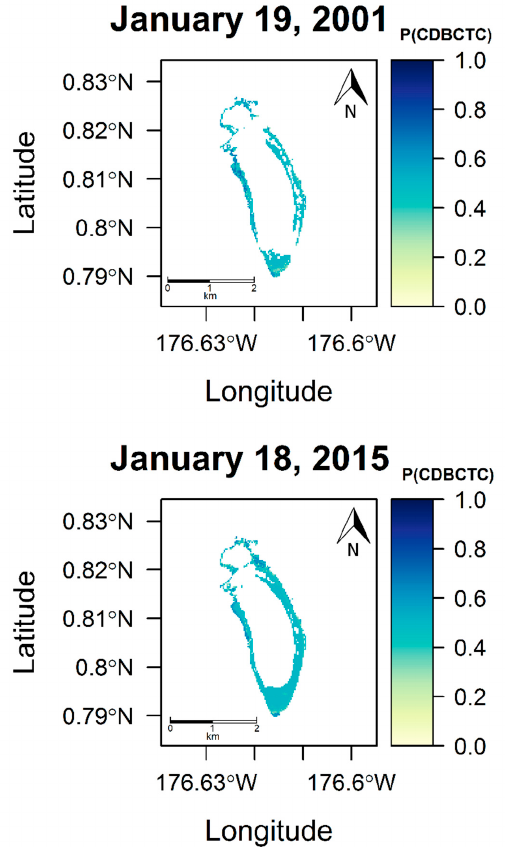
Figure 11. Posterior probability map for the Howland Island area of interest (top, 2001 and bottom, 2015).